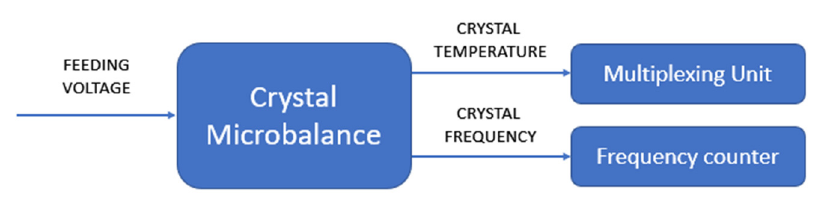
Figure 9. Measurement-chain block diagram.